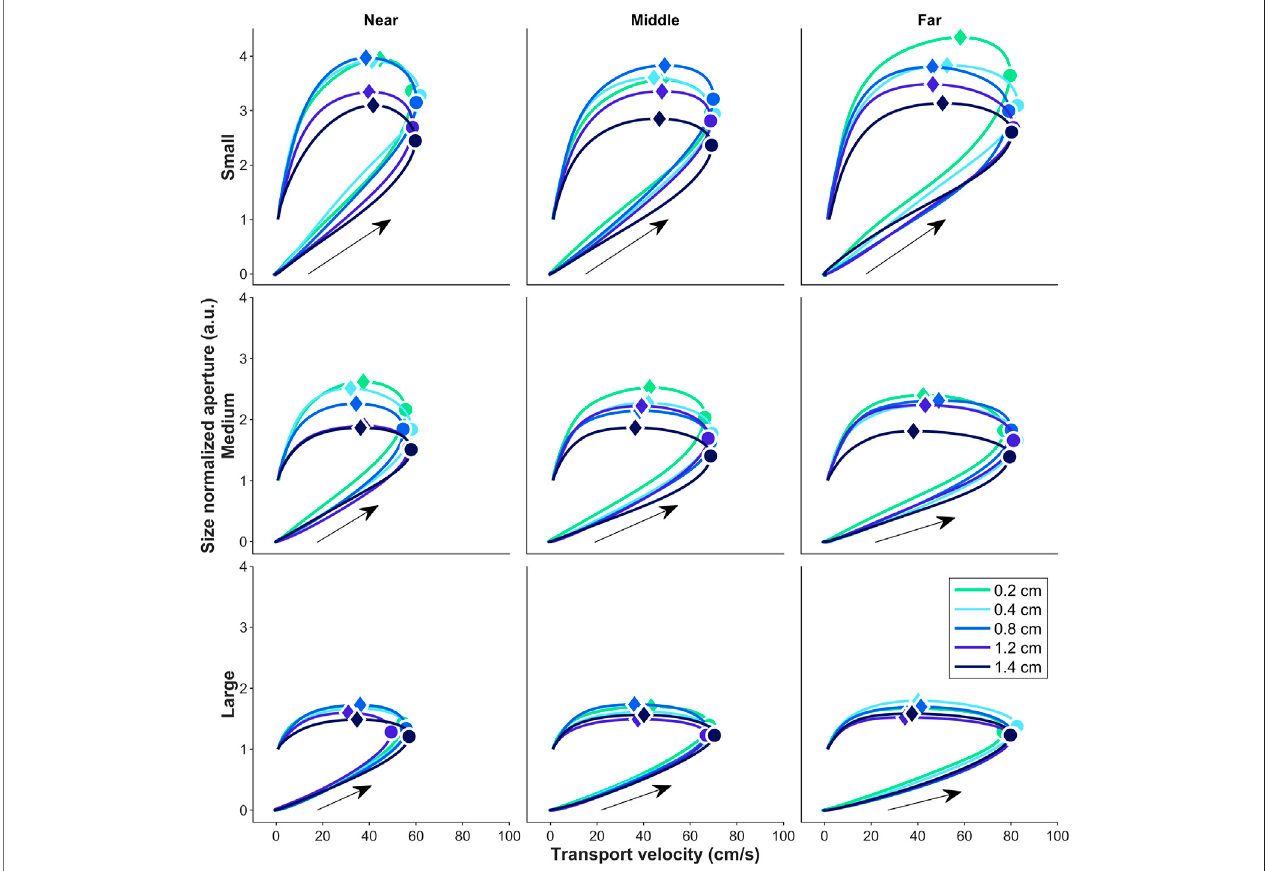
FIGURE 5 | Study 2. Phase plots of size-normalized aperture vs. transport velocity for each collider size for a representative participant. Diamonds and circles indicate size-normalized peak aperture and peak transport velocity, respectively. Black arrows indicate the progression of reach-to-grasp movement.